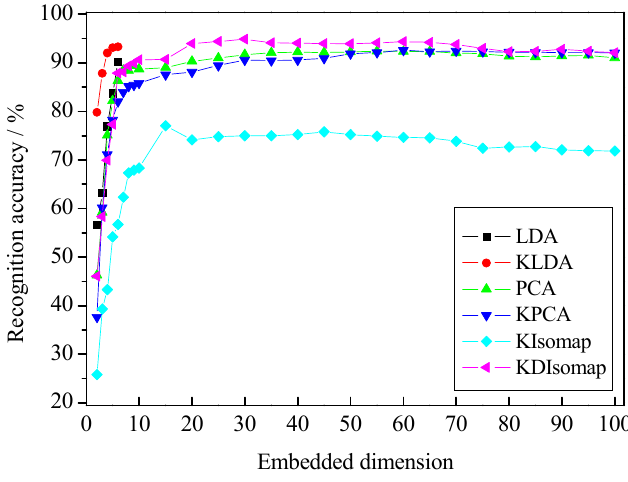
Figure 8. Performance comparisons of different methods on the Cohn-Kanade database.